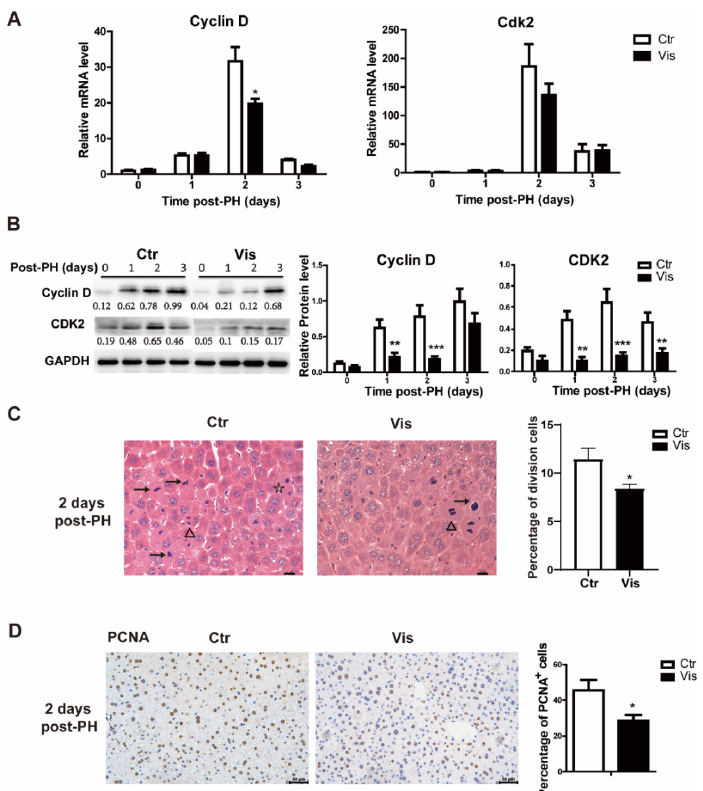
Figure 4. Vismodegib inhibits cell proliferation in the cell cycle at the G1/S phase . ( A ) QRT-PCR analysis of Cyclin D and Cdk2 in the liver tissue at different times after PH between the two groups (1, 2 and 3 days), n = 5. ( B ) Western blot analysis of Cyclin D and Cdk2 in liver tissue at different times after PH. Western blot quantification analysis compared to GAPDH is shown under the bands. ( C ) Quantification of the percentage of cells in different phases of cell division in H&E-stained slices. Arrow ( → ) represents cells of pre-division, triangle ( Δ ) means cells in division and star ( ☆ ) means cells of post-division. Division cells include the three mentioned above. Five full pictures of 20× were counted for each group. Percentage analysis compared to the total cells is shown in the histogram. ( D ) Representative immunohistochemical pictures of PCNA in the liver slices of mice at two days after PH between the two groups. Quantitative analysis is shown in the histogram, n = 3. All data represent means ± SEM. * p < 0.05, ** p < 0.01, *** p < 0.001 vs. control group.